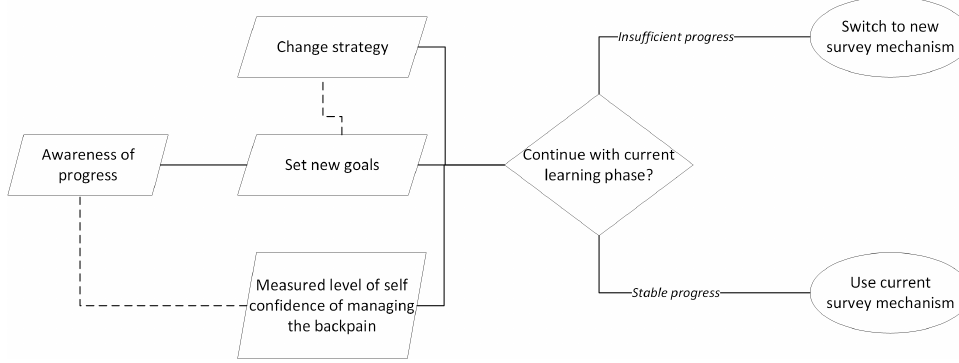
Figure 6. Ontology based approach—level